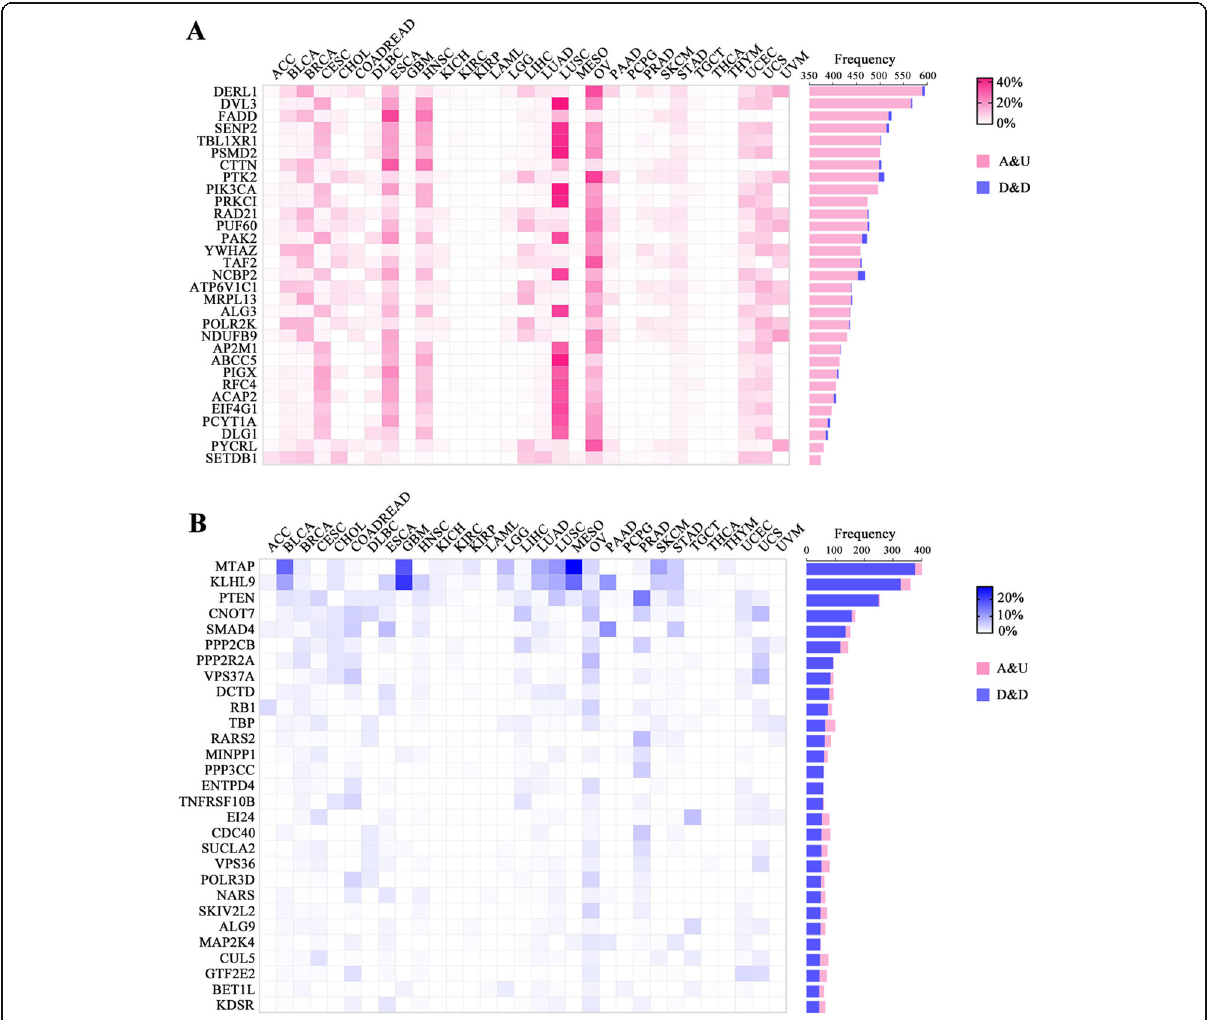
Fig. 4 Identification of AUGs and DDGs across 31 various cancer types in TCGA. a. Representative AUGs (see Methods) were identified by the concordant rate of copy number amplification and expression level upregulation against copy number deletion and expression level downregulation and spearman correlation coefficient (the right barchart). The heatmap (left) shows the corresponding variant rate in each cancer type for each AUG. b . Representative DDGs were identified by the concordant rate of copy number deletion and expression level downregulation against copy number amplification and expression level upregulation and spearman correlation coefficient (the right barchart). The heatmap (left) shows the corresponding variant rate in each cancer type for each DDG. A&U: copy number amplification and expression level